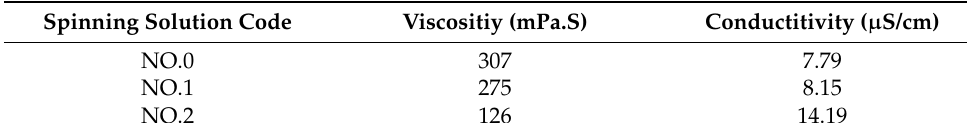
Table 2. Viscosities and conductivities of different spinning solutions.